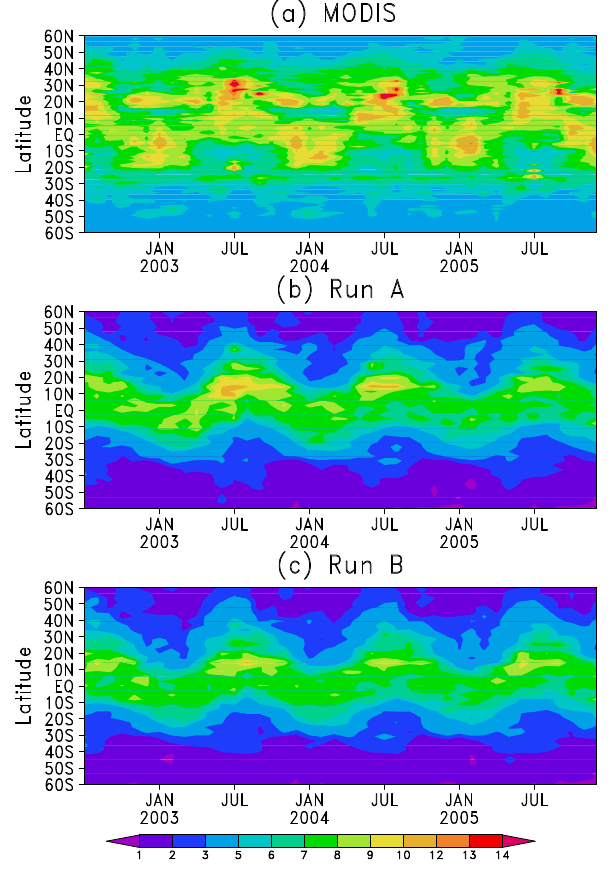
Fig. 8. Time series of monthly mean cloud top height (km) from (a) MODIS (b) run “A E40”, and (c) run “B EI”.